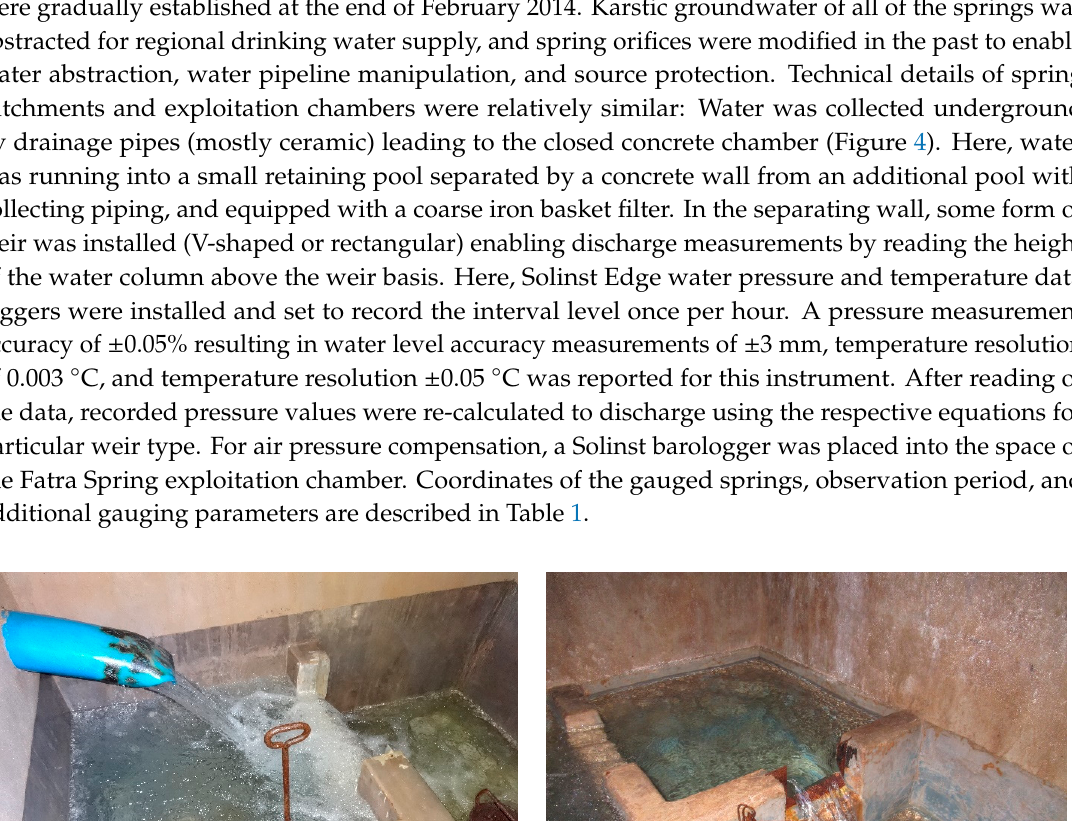
Table 1. Gauged karstic springs of the Kopa Mt. hydrogeological structure and period of discharge hourly gauging.